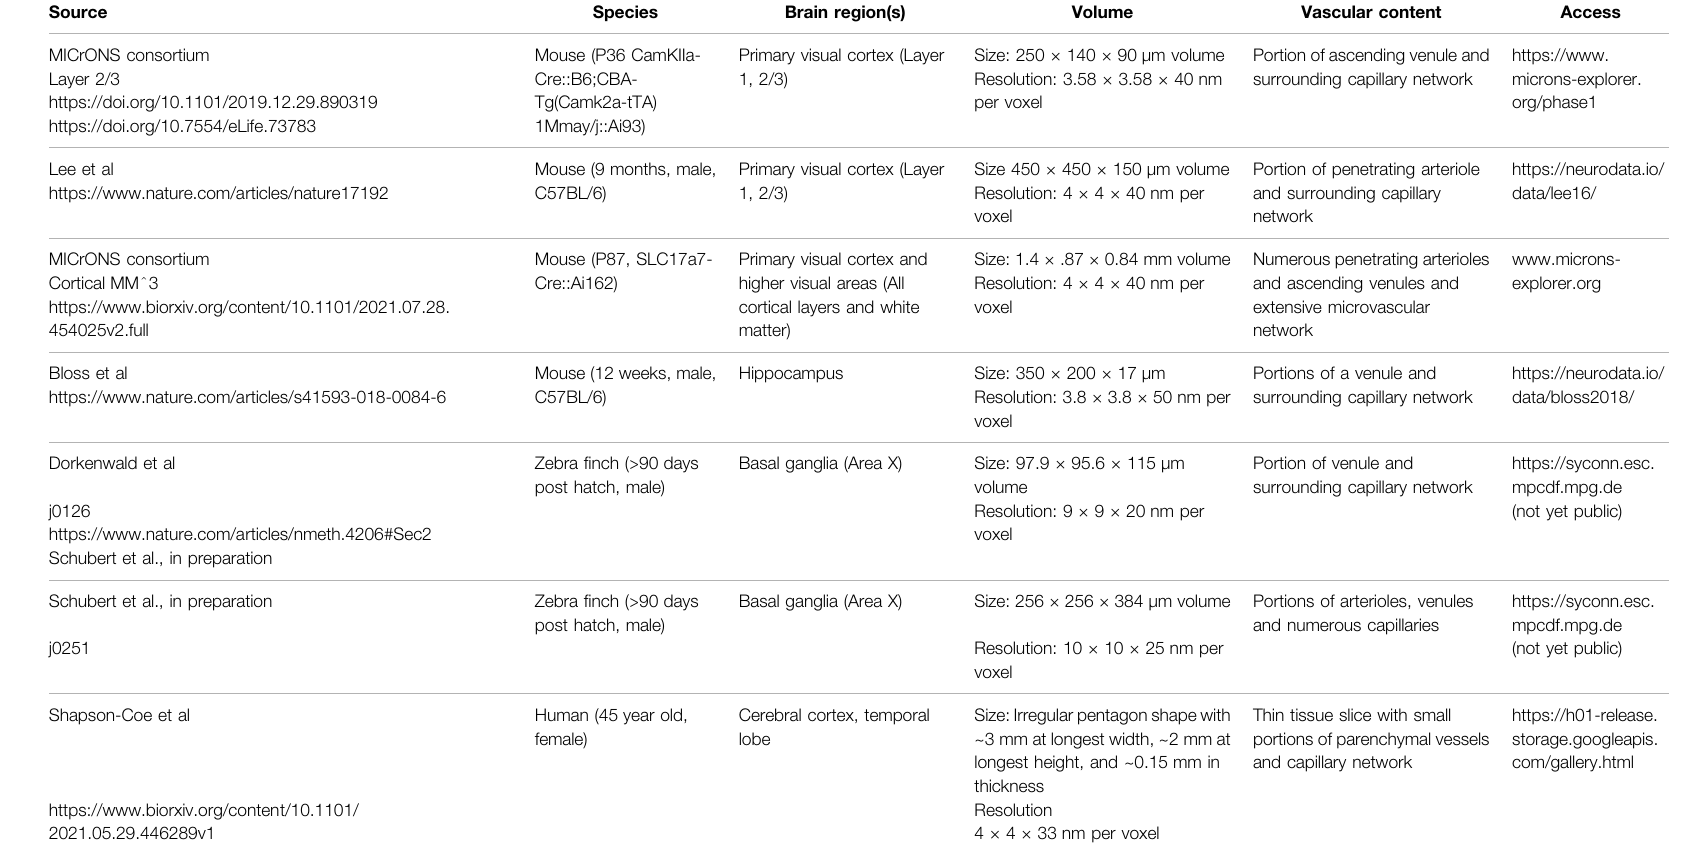
TABLE 1 | Attributes and vascular contents in public 3D-EM data sets from brain